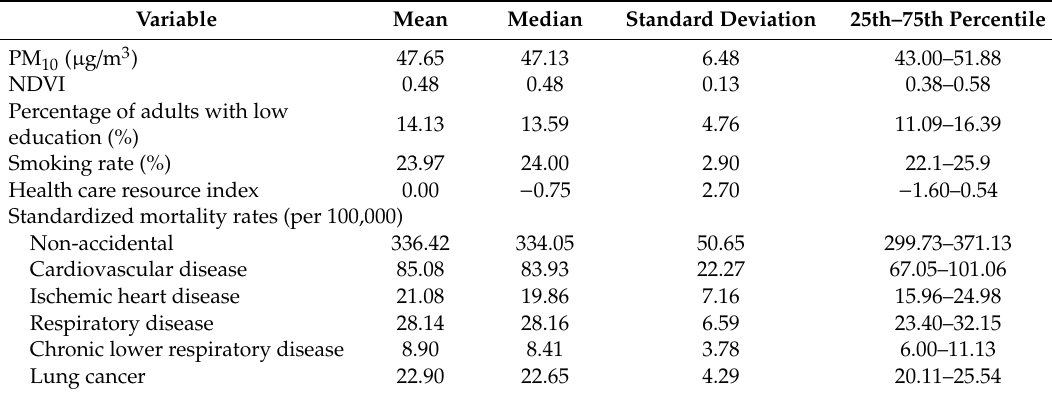
Table 1. Descriptive statistics for study variables in seven metropolitan cities, 2008–2016.